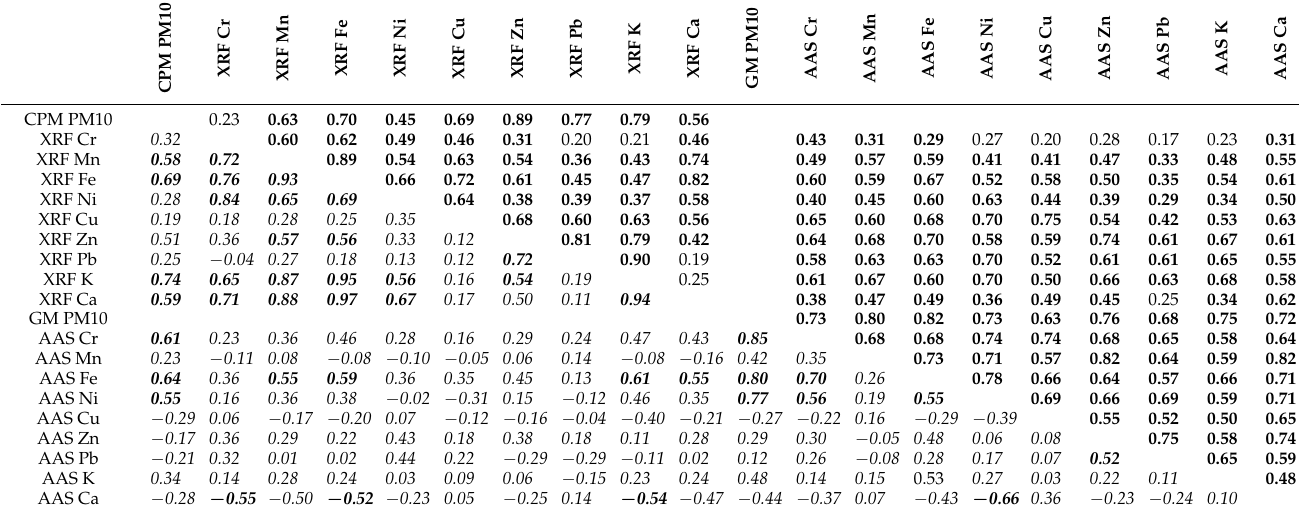
Table 5. Spearman correlation. Relationship between the PM10 concentration and meteorological parameters. Bold values are statistically significant with p = 0.05. Normal font relates to winter data and italic font to spring data.